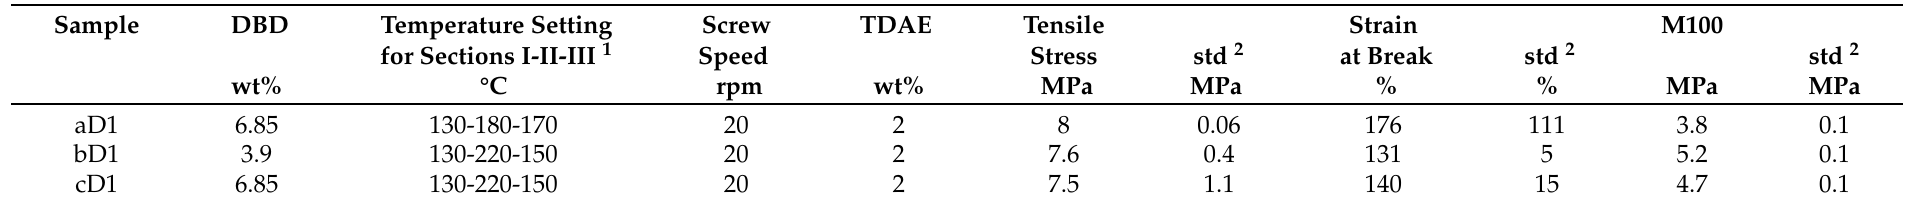
Table 4. Tensile values after re-vulcanization with a silica-silane based formulation. Values after de-vulcanization using screw D , revulcanized with formulation I , Table A3.